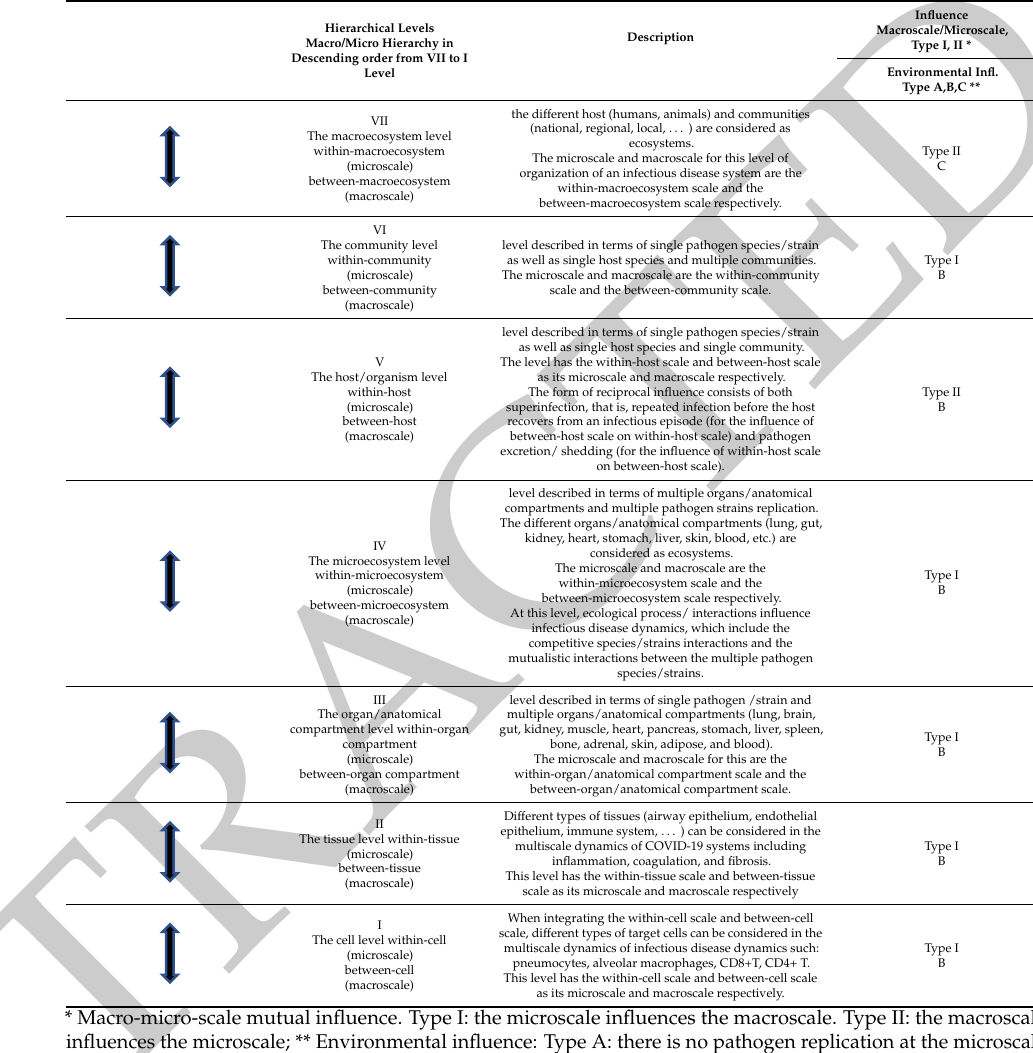
Table 4. Conceptual diagram of the seven hierarchical levels of organization of an infectious disease system and associated macroscale and microscale. Types of reciprocal influences between macroscale, microscale, and environment related to SARS-CoV-2 infection processes. Free adapted and modified from Garira (2020).